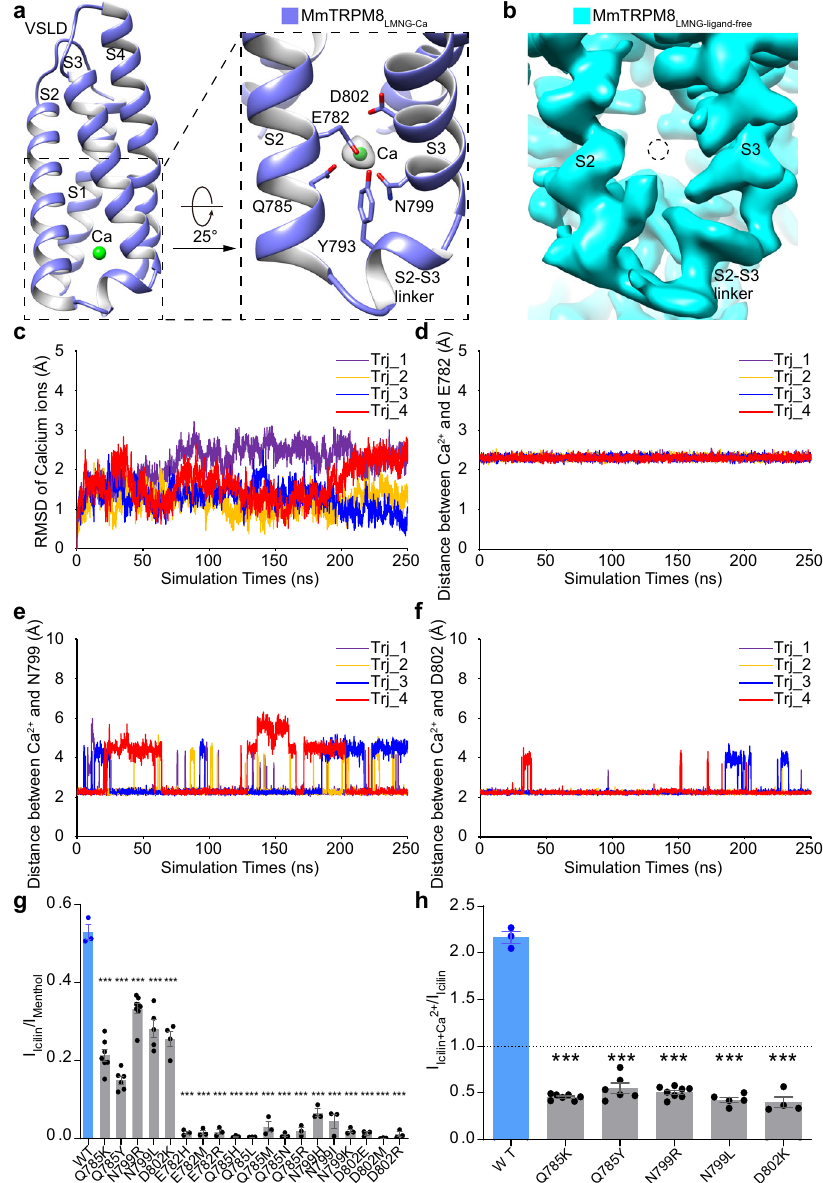
Fig. 5 The Ca 2 + binding site in MmTRPM8. a The VSLD of MmTRPM8 LMNG-Ca harbors a Ca 2 + binding site. The Ca 2 + density is shown at the level of 0.013 in UCSF chimera. b The absence of density at the potential Ca 2 + binding site in VSLD in the map of MmTRPM8 LMNG - ligand-free at the level of 0.013 in UCSF chimera. c The RMSD of the Ca 2 + plotted against simulation time. The distances between the Ca 2 + and CG atoms in Glu782 ( d ), Asn799 ( e ), and Asp802 ( f ) plotted against simulation time. g Summary of MmTRPM8 activated by menthol and icilin. In HEK293T cells expressing WT or mutant MmTRPM8, the application of menthol (2 mM) or icilin (10 μ M) elicited outward currents. For the mutants proposed to be important for Ca 2 + coordination, most of them were no longer activated by icilin. WT and mutants were colored in blue and grey, respectively. For WT MmTRPM8, n = 3; for Q785K, n = 7, P = 2.25E − 06; for Q785Y, n = 6, P = 2.41E − 07; for N799R, n = 8, P = 1.78E − 05; for N799L, n = 5, P = 3.46E − 04; for D802K, n = 4, P = 1.99E − 04; for E782H, n = 3, P = 1.23E − 05; for E782M, n = 3, P = 1.34E − 05; for E782R, n = 3, P = 1.41E − 05; for Q785H, n = 3, P = 1.06E − 05; for Q785L, n = 3, P = 1.04E − 05; for Q785M, n = 3, P = 2.81E − 05; for Q785N, n = 3, P = 1.14E − 05; for Q785R, n = 3, P = 1.61E − 05; for N799H, n = 3, P = 2.79E − 05; for N799I, n = 3, P = 5.56E − 05; for N799K, n = 3, P = 1.31E − 05; for D802E, n = 3, P = 1.21E − 05; for D802M, n = 3, P = 1.02E − 05; for D802R, n = 3, P = 1.33E − 05. Two-sided t -test; *** denotes P < 0.001. All data points are mean ± s.e.m. h Summary of MmTRPM8 and mutants activated by icilin alone (10 μ M) or in the presence of Ca 2 + (1 mM). WT and mutants were colored in blue and grey, respectively. For WT MmTRPM8, n = 3; for Q785K, n = 7, P = 1.62E − 10; for Q785Y, n = 6, P = 3.87E − 07; for N799R, n = 8, P = 1.02E − 10; for N799L, n = 5, P = 1.03E − 07; for D802K, n = 4, P = 4.98E − 06. Two-sided t -test; *** denotes P < 0.001). All data points are mean ± s.e.m. For c – h , source data are provided as a Source Data fi le. Fig. 11h), similar to the Ca 2 + -bound MmTRPM8 LMNG-Ca struc- subunit (Supplementary Fig. 11a, g). As analyzed above, all MmTRPM8 structures are in the same closed state, similar to the ture. Ca 2 + binding at the VSLD in PmTRPM8 seems to stabilize the intact structure of the transmembrane domain. Without closed states of MmTRPM4 and MmTRPM7. Therefore, it is Ca 2 + , the selectivity fi lter and outer pore loop of PmTRPM8 likely that PmTRPM8 Ca is also in the closed state (Supplementary NATURE COMMUNICATIONS| (2022) 13:3113